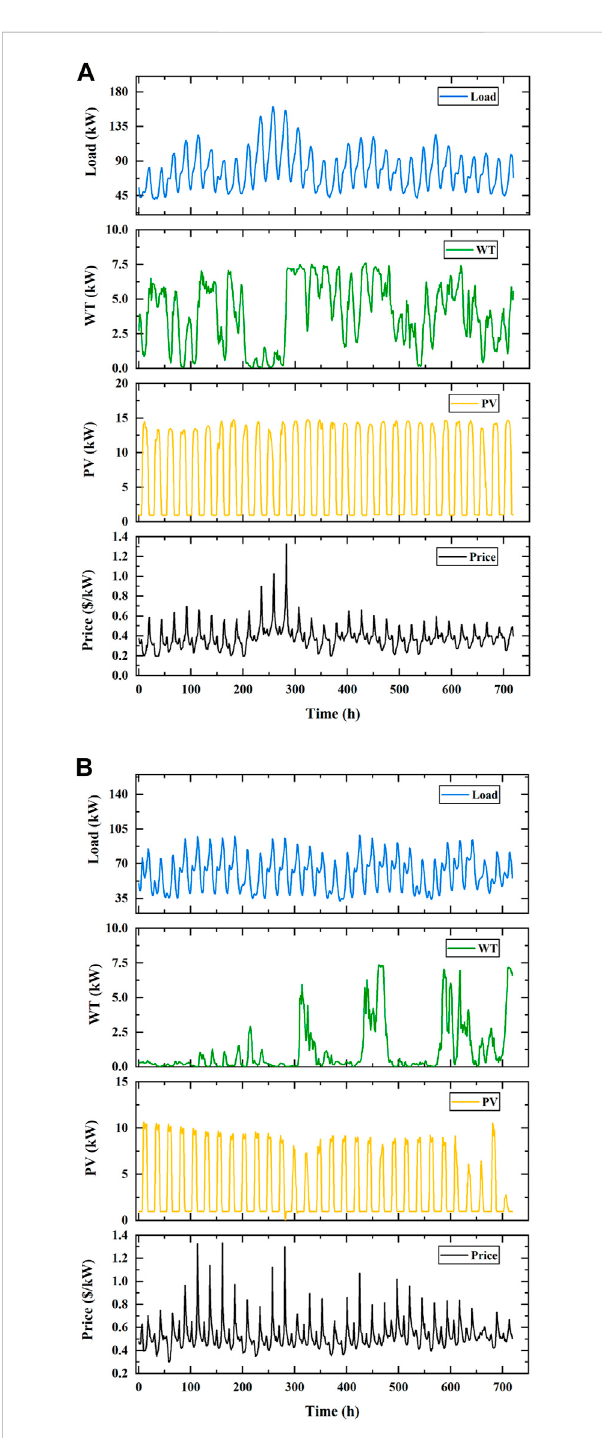
FIGURE 10 Test data used in the experiment with stochastic scenarios: (A) Data for June in the test set; (B) data for November in the test